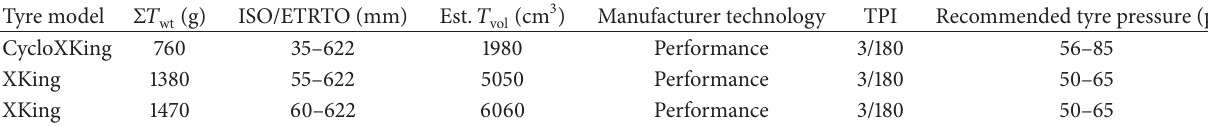
Table 1: Characteristics of the tyres used during the study.